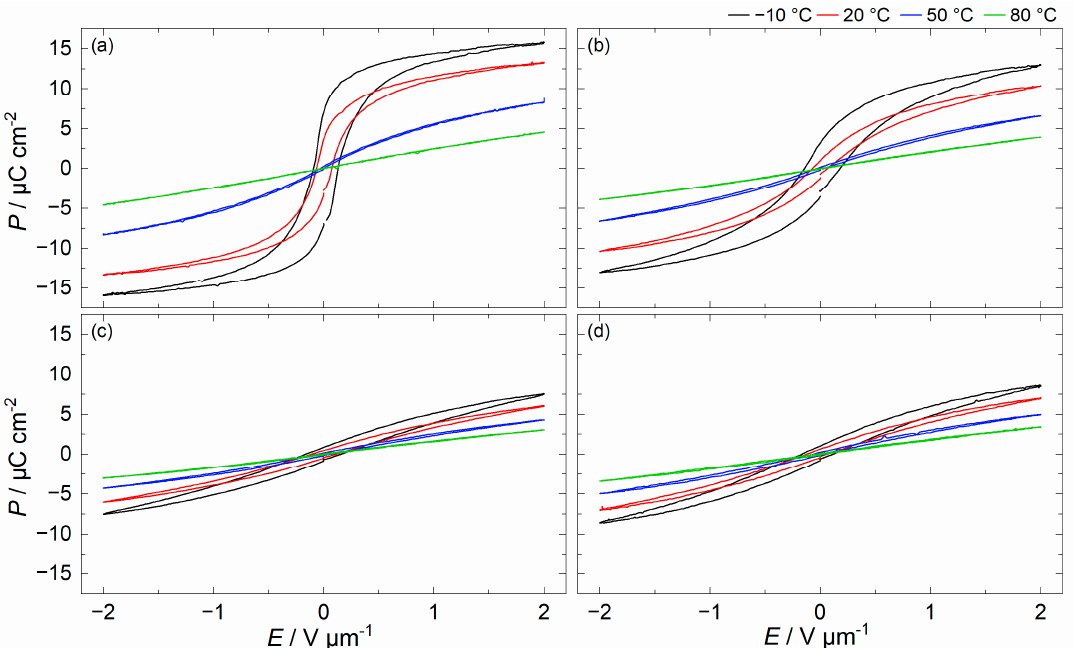
Figure 7. Hysteresis loops measured at − 10, 20, 50, 80 °C and 10 Hz for BSSnT-18-6.5 ( a ), BSSnT-Cu